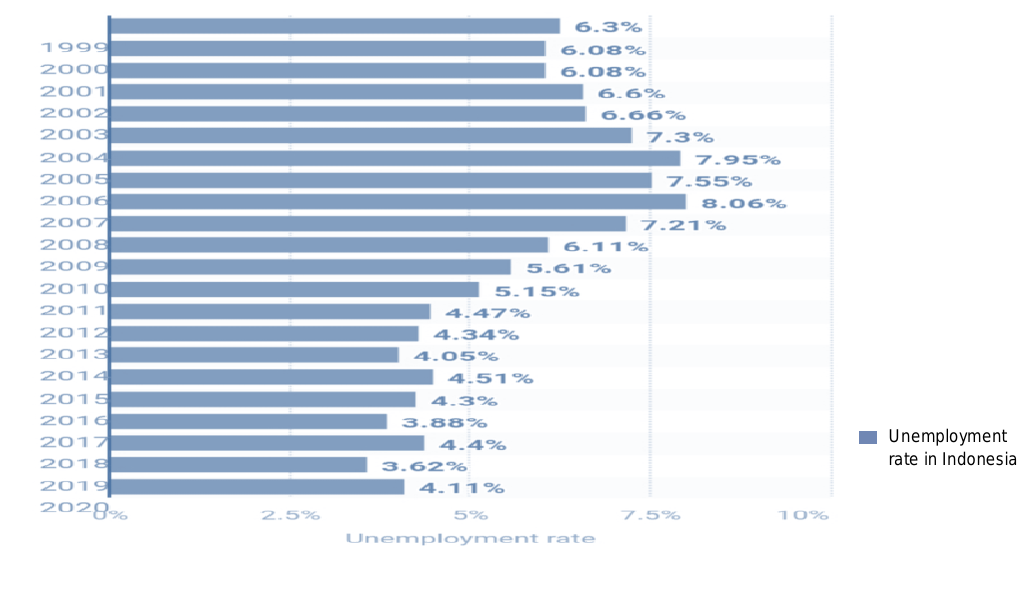
Figure 3: Indonesia: Unemployment Rate from 1999 to 2020; Source: The unemployment rate in Indonesia 2020 by O'Neill ,2021